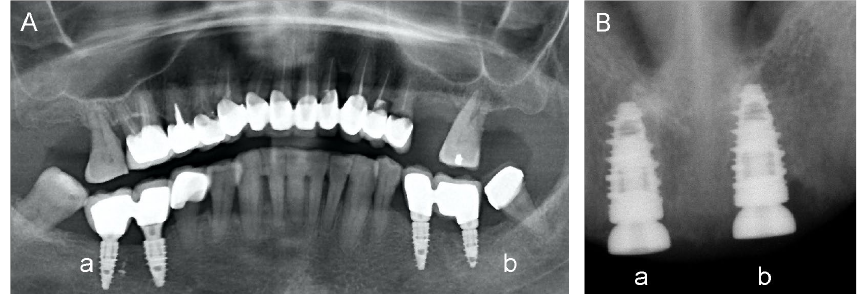
Figure 7. Sample images of dental implants with or without CGF permeation. Patients treated with split-mouth with universe type IML implants. ( A ) CGF-permeated implants in quadrant IV (a, right side) showed better crestal level and probing, and less bleeding when compared with those executed in quadrant III without CGF (b, left side), showing bone resorption problems. ( B ) CGF-permeated implants in quadrant I (a, right side) and in quadrant II without CGF (b, left side).